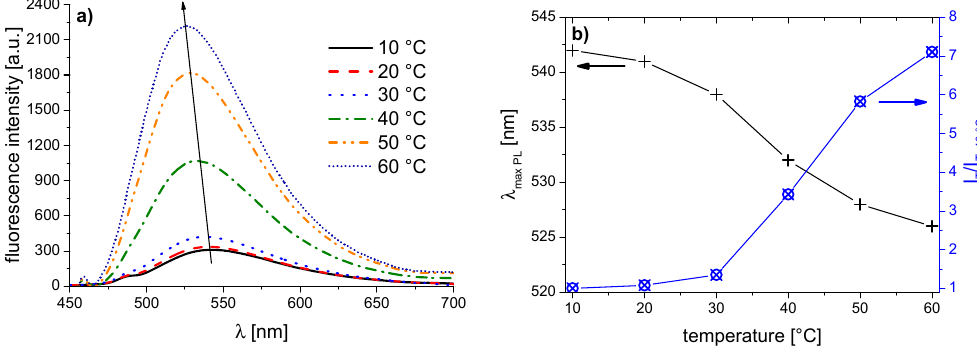
Figure 7. Temperature dependent fluorescence behavior of PNVCL-c in aqueous solution (concentration 0.10 g·L − 1 ): ( a ) normalized emission spectra ( λ Exc = 418 nm); and ( b ) evolution of λ maxEm of the emission band, and of the fluorescence intensity normalized to 10 °C.